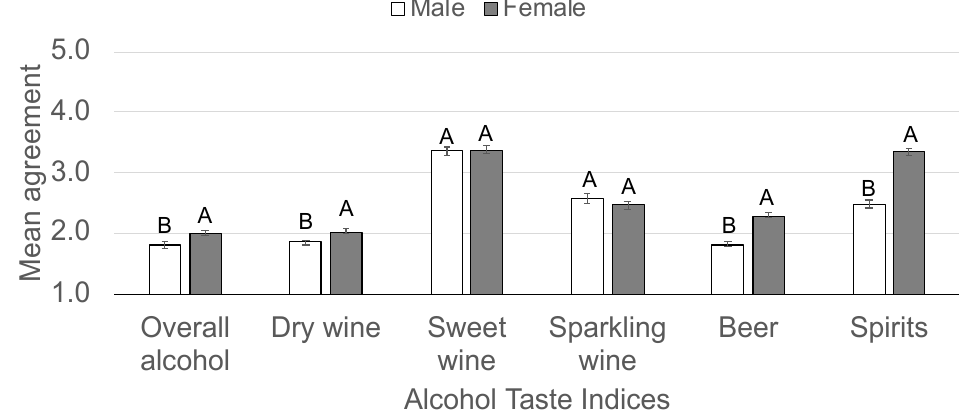
Figure 5. Mean scores for the alcohol taste indices grouped by PROP taster status (255 pNT, 459 pMT, 165 pST). Significantly different means from three-way ANOVAs indicated with different letters.